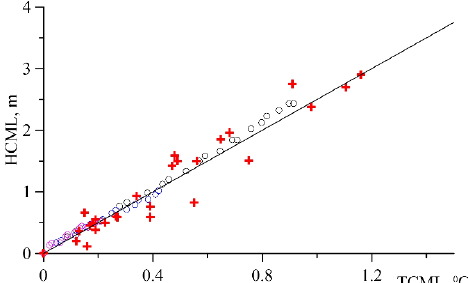
Figure 9. CML temperature as a function of the CML lower boundary depth: comparison of the simulation and observational data with the correlation [Equation (10)]: black symbols — Variant 1, blue — Variant 2, purple — Variant 3, red symbols — observational data, black line — correlation.